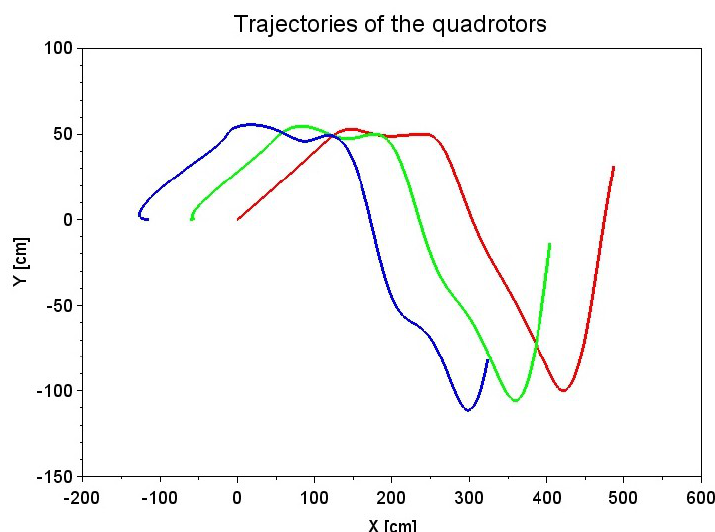
Figure 8. Trajectory of the quadrotors in Experiment 1 under wind perturbations. Color code: red, green and blue correspond to leader, mid and rear drones,